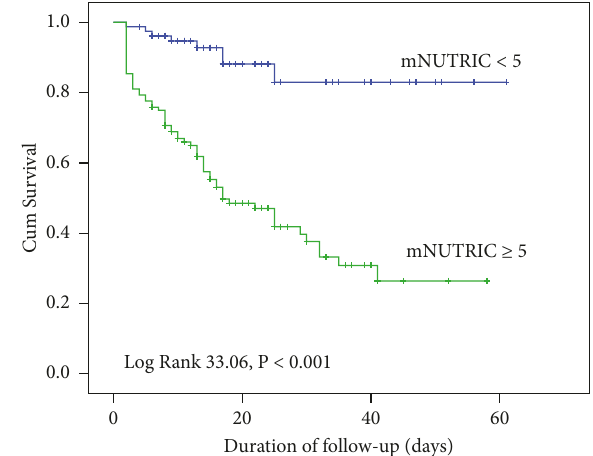
Figure 3: Mortality of septic patients in-hospital according to mNUTRIC score < 5 or mNUTRIC score ≥ 5.